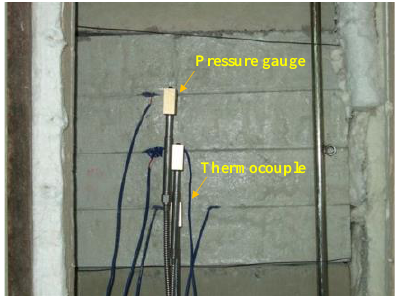
Figure 4. Specimen installation and sensor configuration.